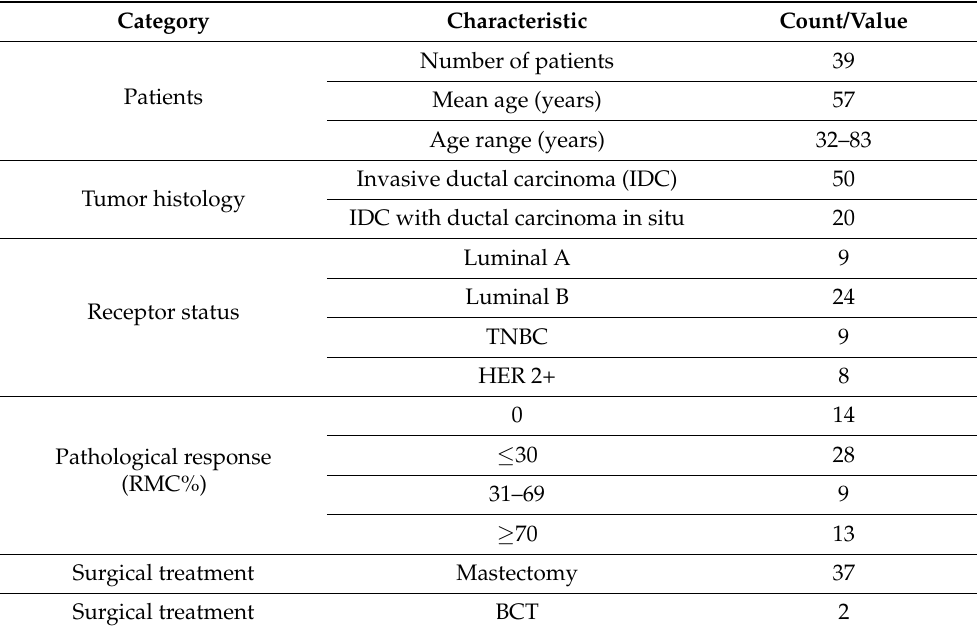
Table 1. Characteristic of the patients group, including histological findings.